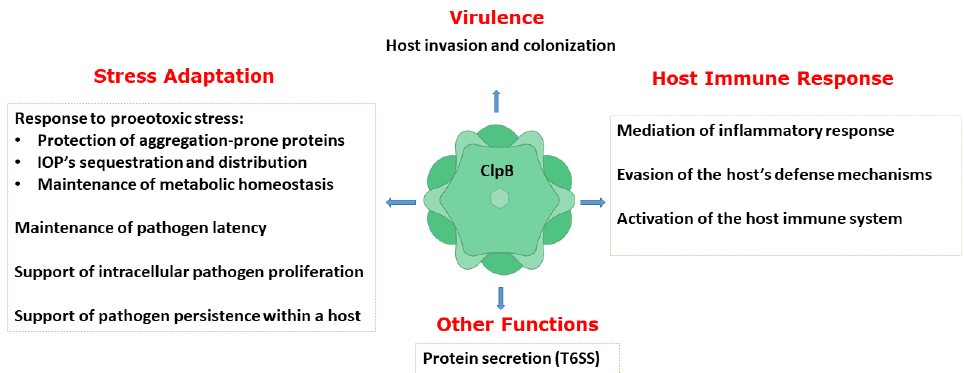
Figure 3. Summary of the documented functions of ClpB in supporting virulence, host − pathogen interactions, and stress adaptation in pathogenic bacteria. IOPs: irreversibly oxidized proteins; T6SS: type VI secretion system.